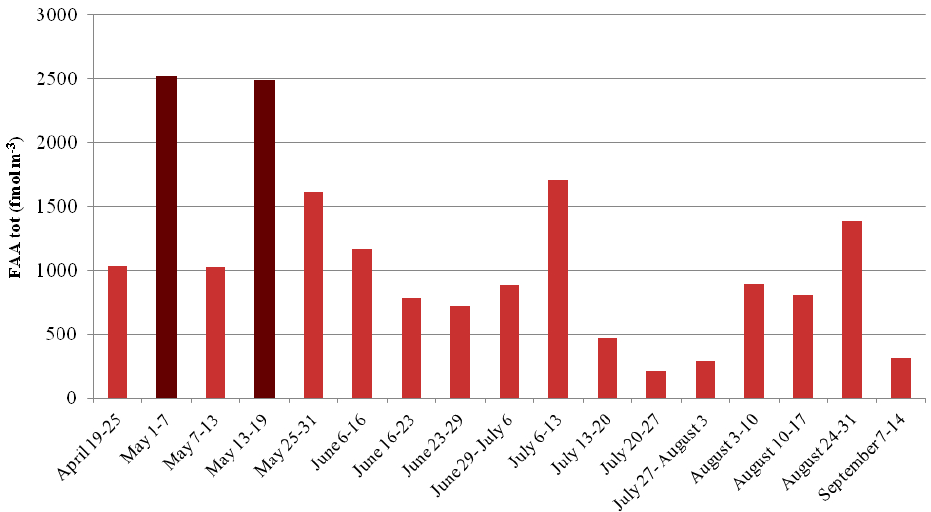
Fig. 5. Total amino acid concentrations in the < 0.49µm filters (fmolm − 3 ) demonstrating the influence of local fires and regional volcanic activity in the samples from 1–7 and 13–19 May.